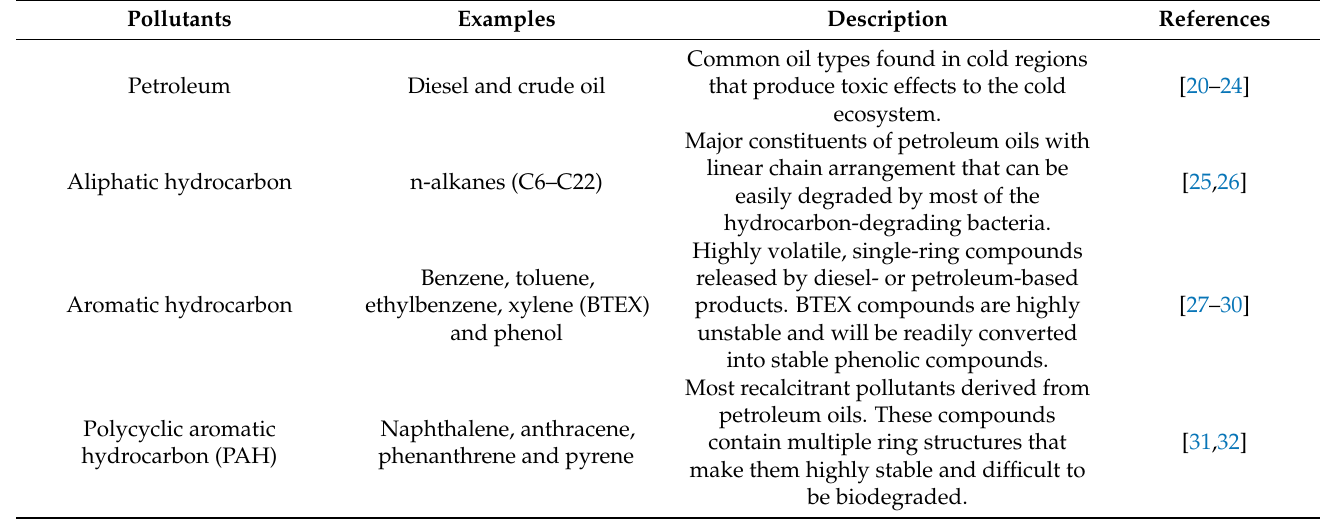
Table 1. Petroleum pollutants generated from oil spillages in cold